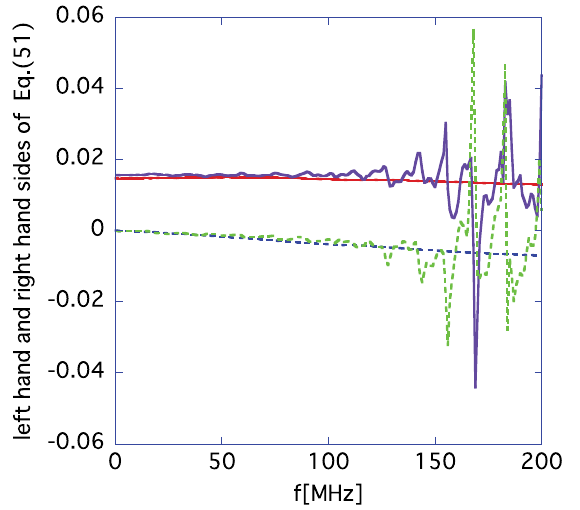
the upper figures of Fig. 4.